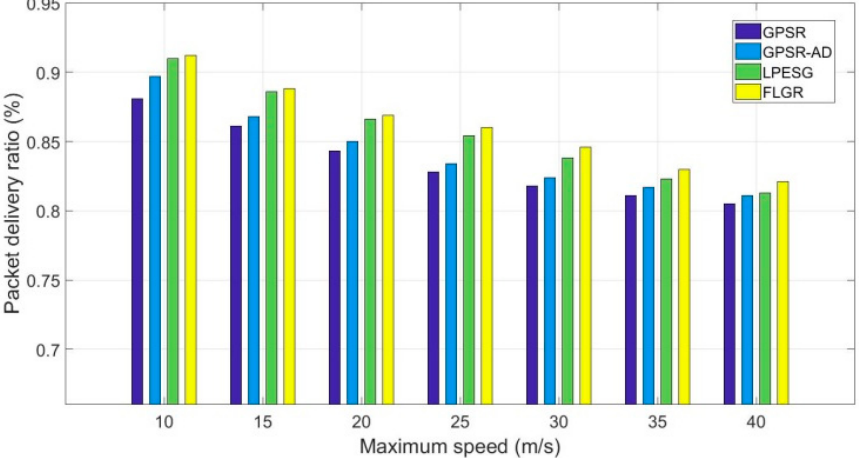
Figure 10. Impact of maximum speed on packet delivery ratio with 60 n = .